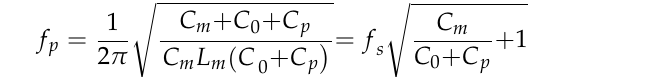
Table 1. Calculated capacitance with support columns of different widths.